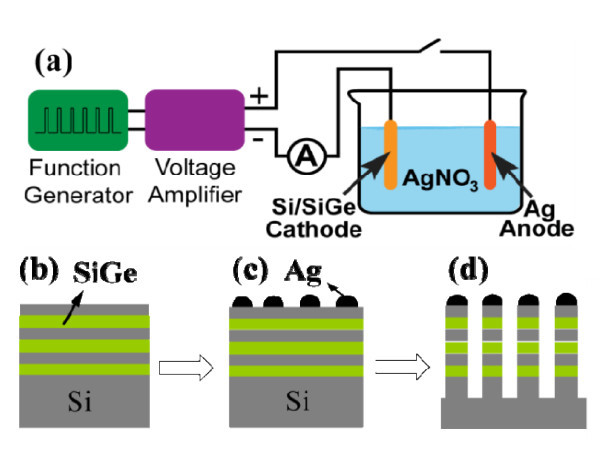
Schematic diagram of the AgNP-based nanowire fabrication sequence. (a) Experimental setup of ECD and fabrication steps of superlattice nanowires. (b) CVD growth of 2D superlattice. (c) ECD of NPs. (d) Plasma etching to create superlattice nanowires.